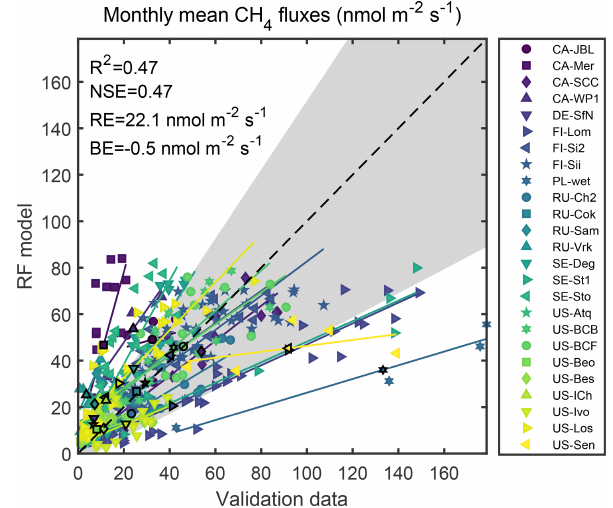
Figure 4. Relation between monthly mean CH 4 fluxes predicted by the RF model and independent validation data. Monthly average values from the same site are identified by unique colours and a least-squares linear fit to data from each site is also plotted using the same colour. Site means are shown with markers with black edges. The dashed line shows the 1 : 1 line. The shaded area shows the uncertainty range estimated from the RE CH 4 flux dependence (see text for further details). The statistics in the figure are calculated using the monthly data. See Appendix A for an explanation of site